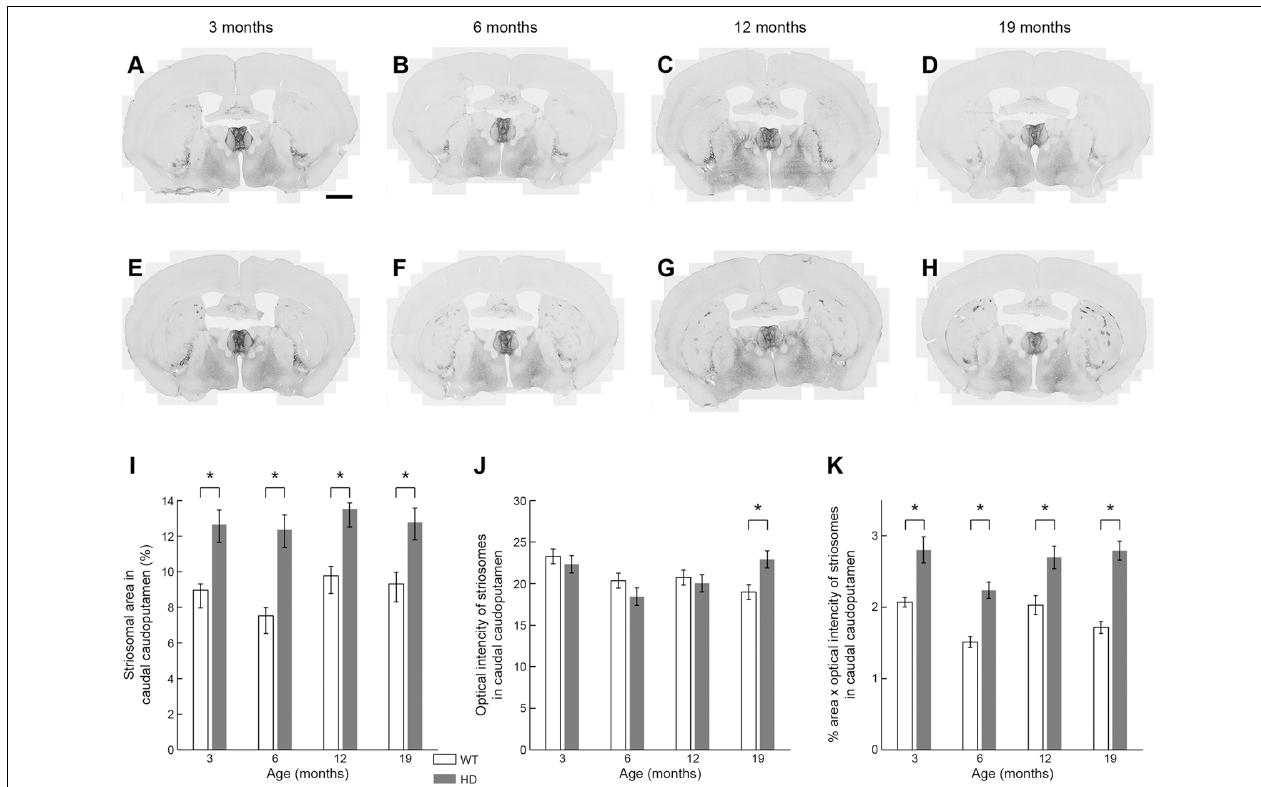
FIGURE 6 | Histological evaluation of the MOR1 labeling across four different ages in the caudal caudoputamen of WT and Q175KI mice. The background signals were subtracted using the “Rolling Ball” command (radius = 500 pixels) of Fiji software. At all ages (3, 6, 12, and 19 months), the MOR1-immunopositive area increased in Q175KI (E–H) relative to WT (A–D) mice (I) . The mean intensity of the MOR1-immunopositive area was increased only at 19 months ( p = 0.003; J ). The whole intensity of MOR1-immunopositive area (intensity × %area) increased at all ages ( p < 0.001 at 6 and 19 months, p = 0.001 at 3 months, and p = 0.006 at 12 months of age; K ). Asterisks indicate significant differences ( p < 0.005 after Bonferroni correction). Processed images were inverted. Scale bar = 1